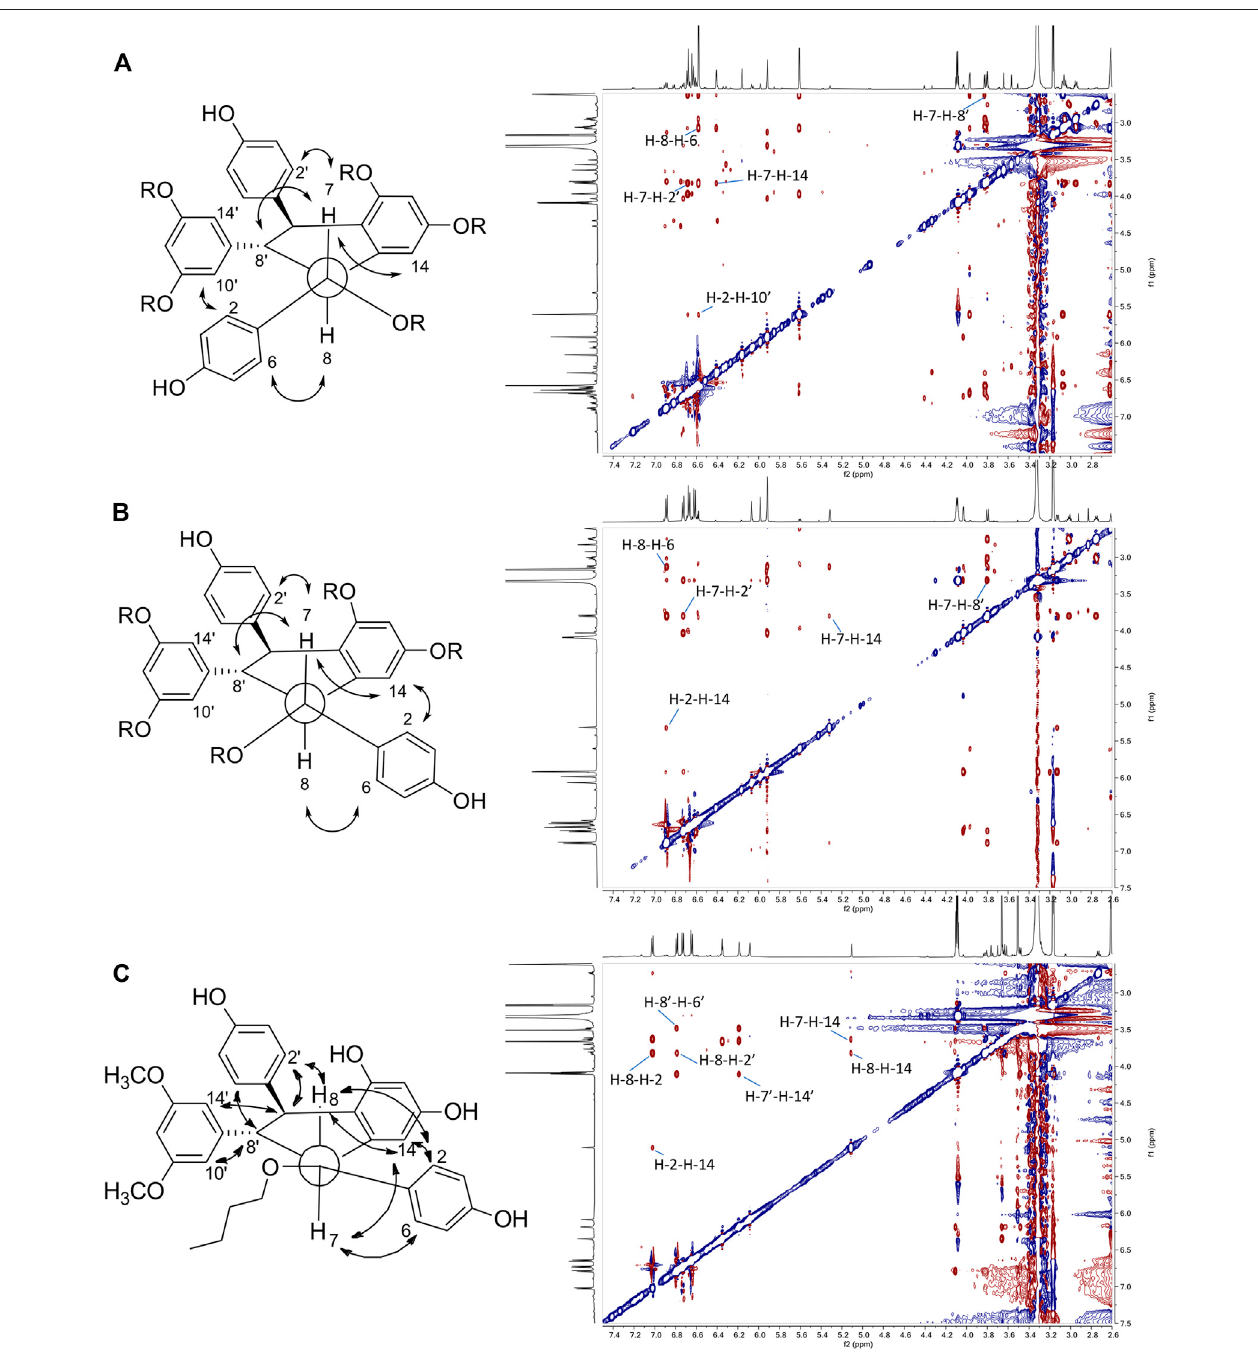
FIGURE 6 | Key ROESY correlations observed for (A) leachianol F series (B) leachianol G series and (C) for the different isomer (compound 32 ).